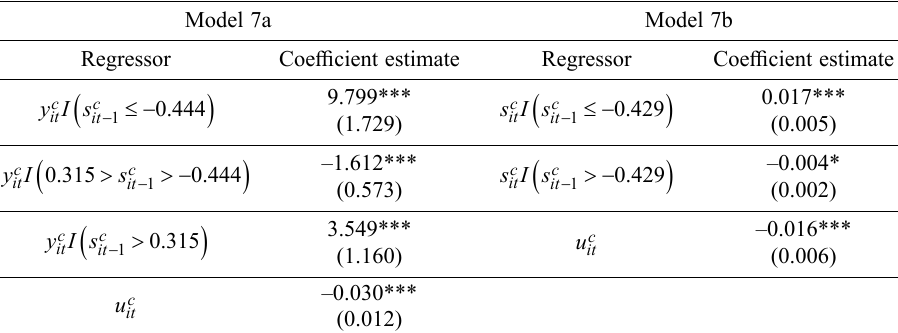
Table 4. Regression estimates of